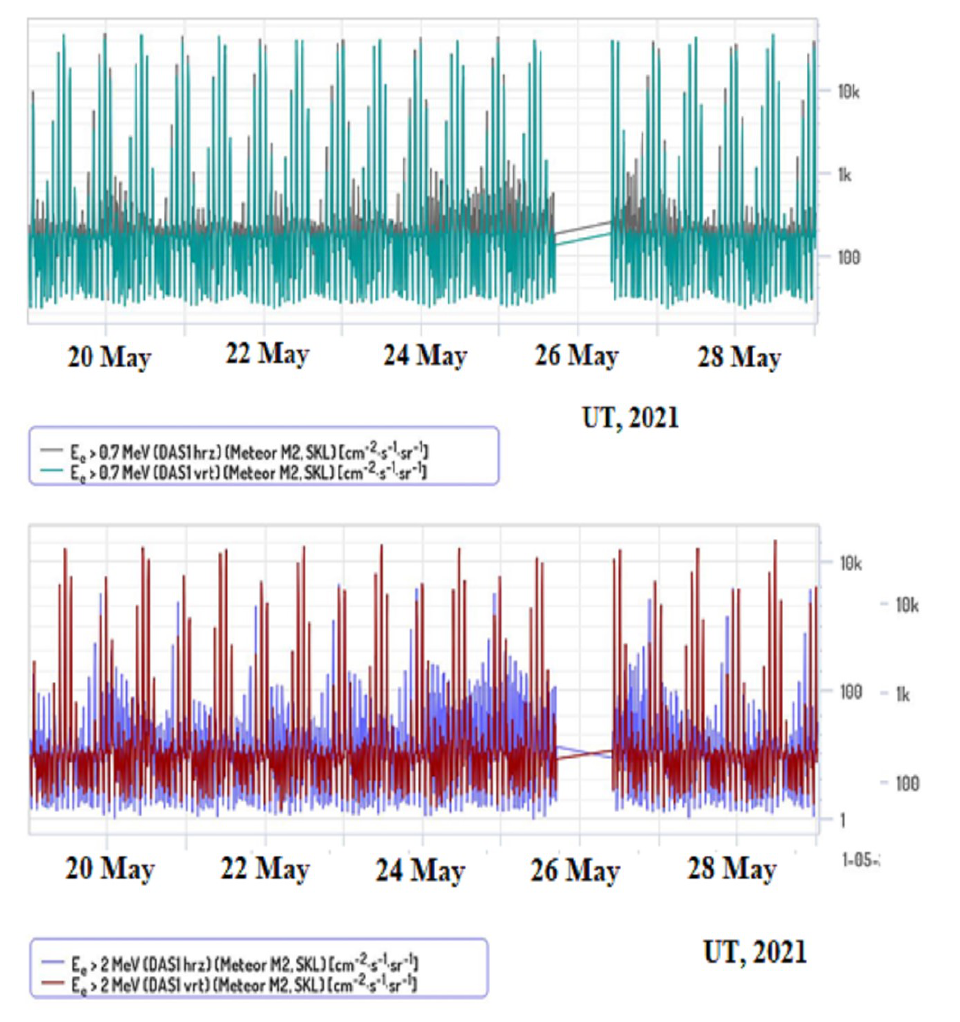
Fig. 2. Time profiles of the ERB electron fluxes in the ranges >0.7 MeV (upper panel) and >2 MeV (bottom panel) obtained from polar orbit 19-28.05.2021.